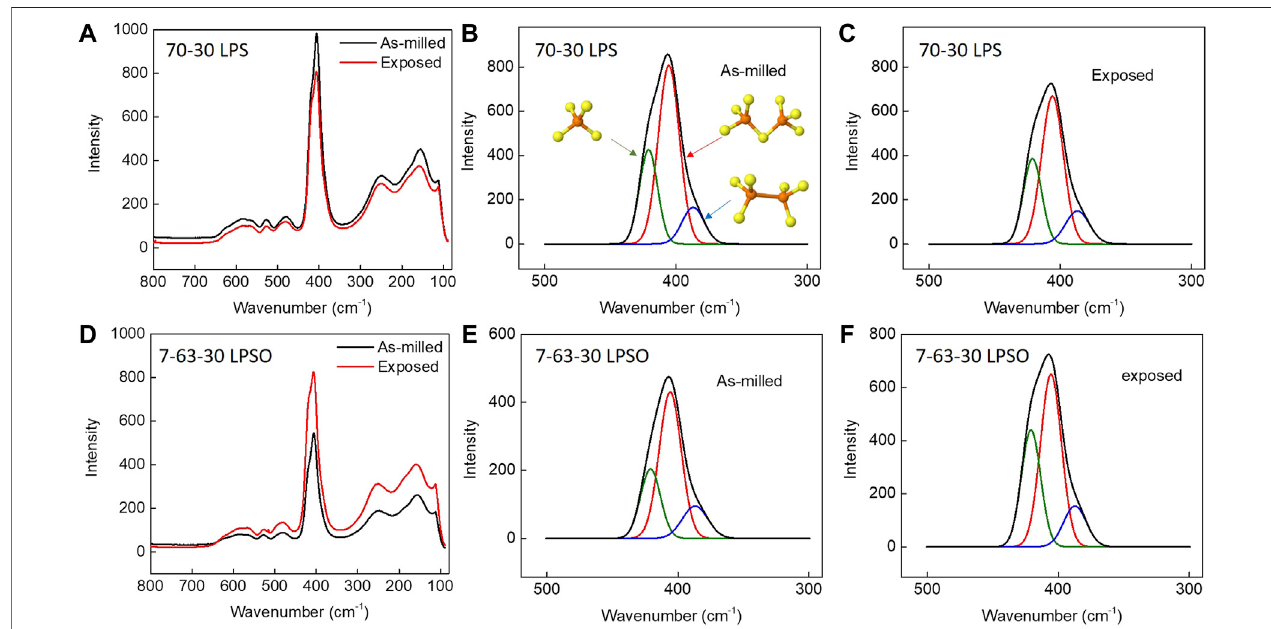
FIGURE7| Ramanspectraofsul fi deSSEsbeforeandafterexposuretoa − 40 ° Cdewpointdryroomenvironmentfor30 min.Theprimarypeakwasdeconvoluted into three peaks attributed to PS 43- (green, 420 cm − 1), P 2 S 74- (red, 406 cm − 1), and P 2 S 64- (blue, 387 cm − 1) structural units. (A) Raman spectra for 70-30 LPS before and after exposure. (B) Fitted Raman spectrum for 70-30 LPS before exposure. Insets provide ball and stick models for PS 43- , P 2 S 74- , and P 2 S 64- structural units. (C) Fitted Raman spectrum for 70-30 LPS after exposure. (D) Raman spectra for 7-63-30 LPSO before and after exposure. (E) Fitted Raman spectrum for 7-68-30 LPSO before exposure. (F) Fitted Raman spectrum for 7-68-30 LPSO after exposure.